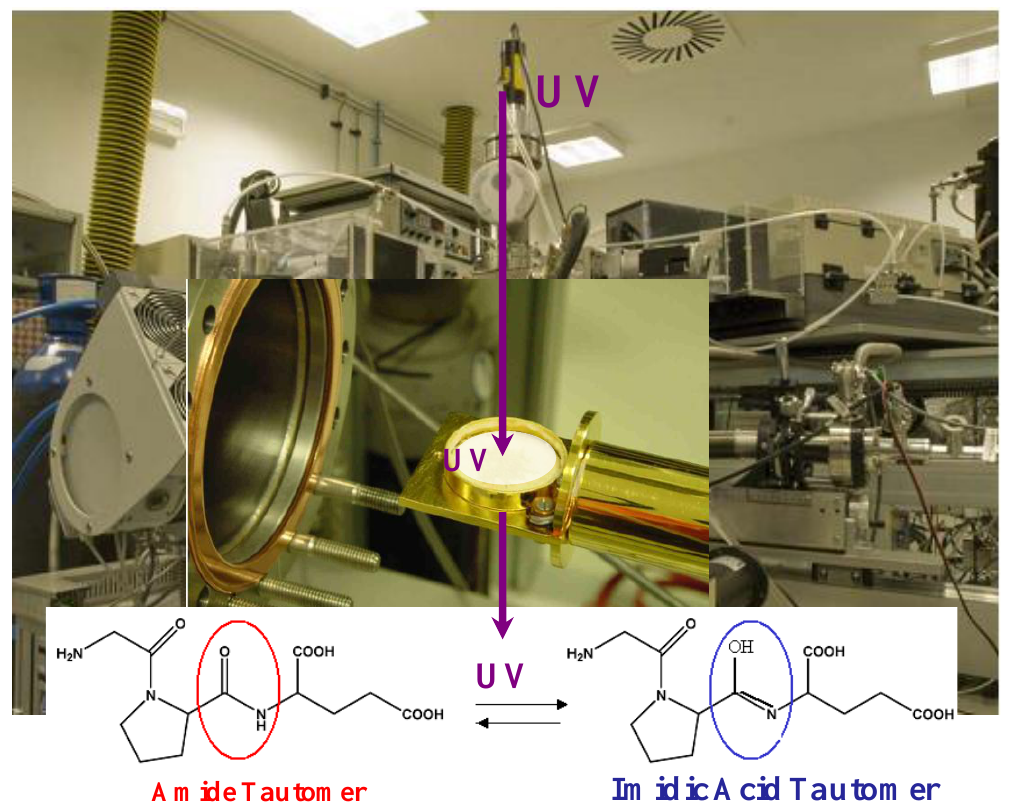
Figure 2. Testing peptides Ar + matrix stability under UV irradiation, which induces a chemical tautomeric